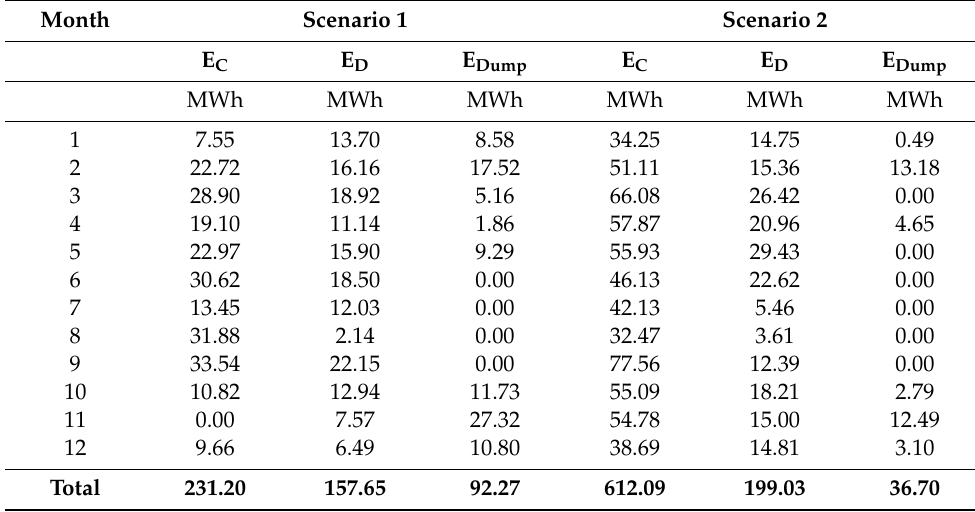
Figure 14. Charge and discharge hourly power behavior and storage fractional state of charge for ( a , c ) scenario 1 ; ( b , d ) scenario 2 . Table 8. Monthly energy performance of the